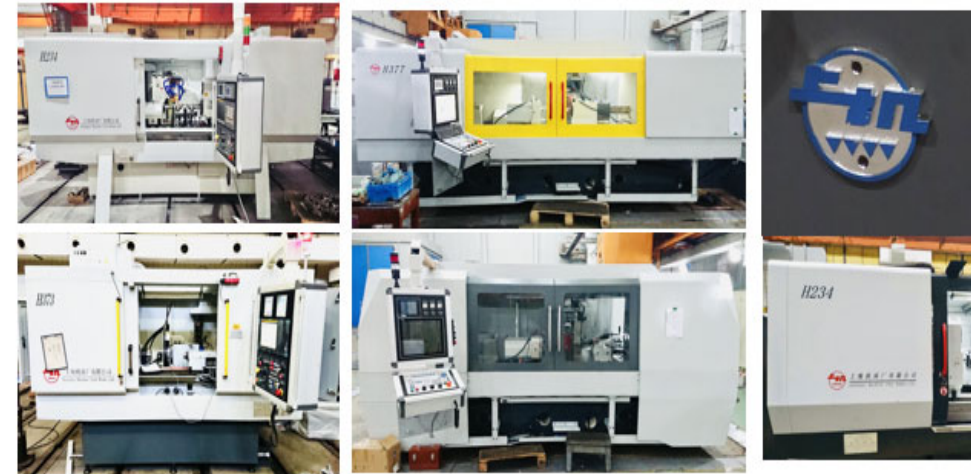
Figure 1. Different types of machine tools from Shanghai Machinery Factory.